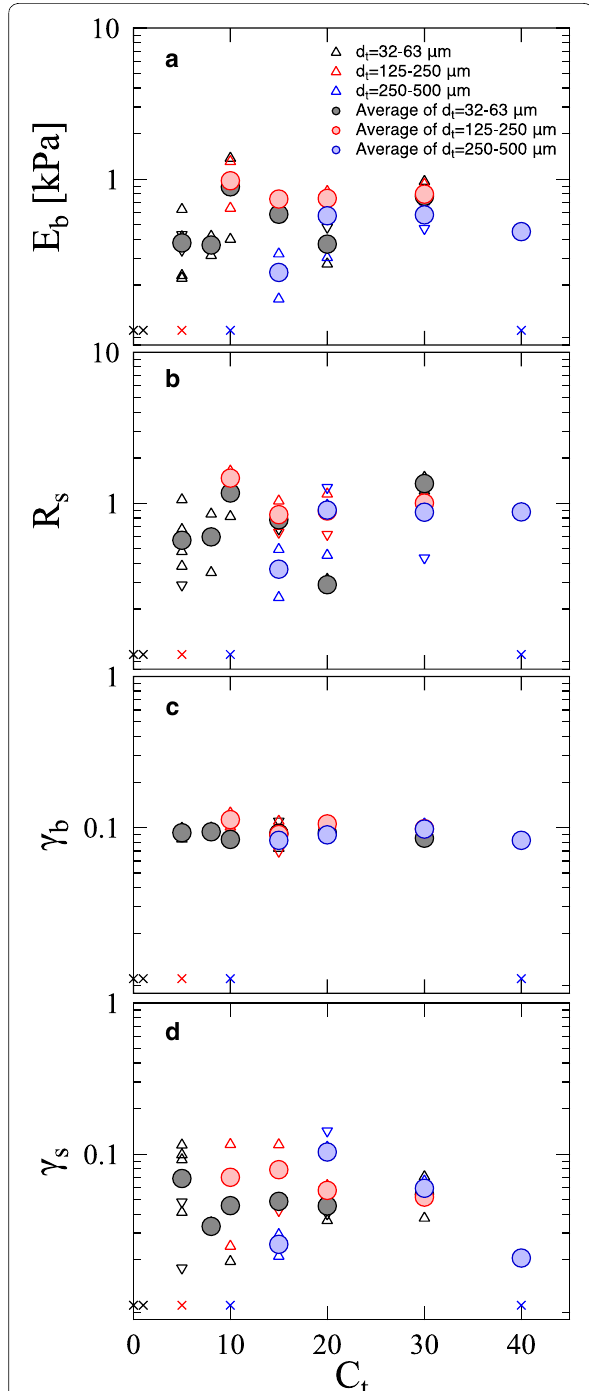
Fig. 12 Analysis results of compression tests. Estimated characteristic quantities vs. C t : a E b , b R s , c γ b , and d γ s obtained from EXP3–5. Triangles show all measured results and circles correspond to the average of data collected under identical experimental conditions. Up-pointing triangle and down-pointing triangle denote the measured results of the largest and second largest aggregates. Although the characteristic quantities fluctuate around certain mean values, it is difficult to observe any clear trend in the